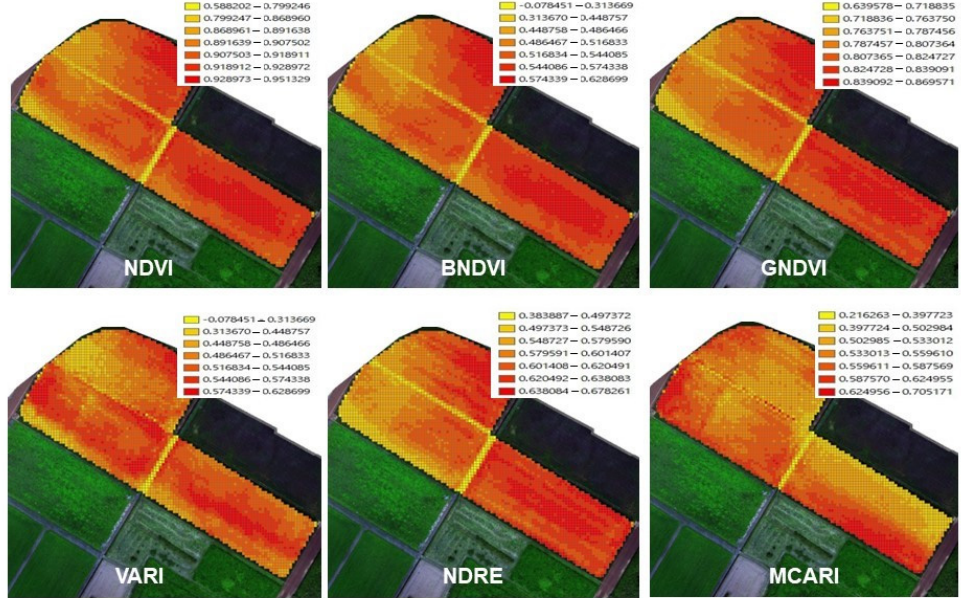
Table 2. Correlation matrix of six vegetation indices of paddy field in 8th July 2020 (early repro-